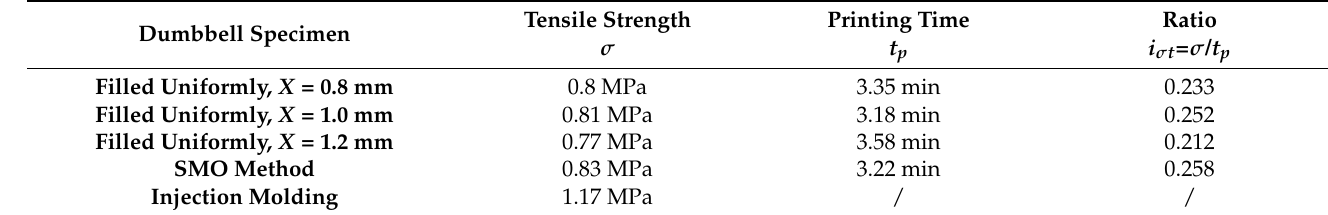
Table 3. Printing efficiency of different filling methods.